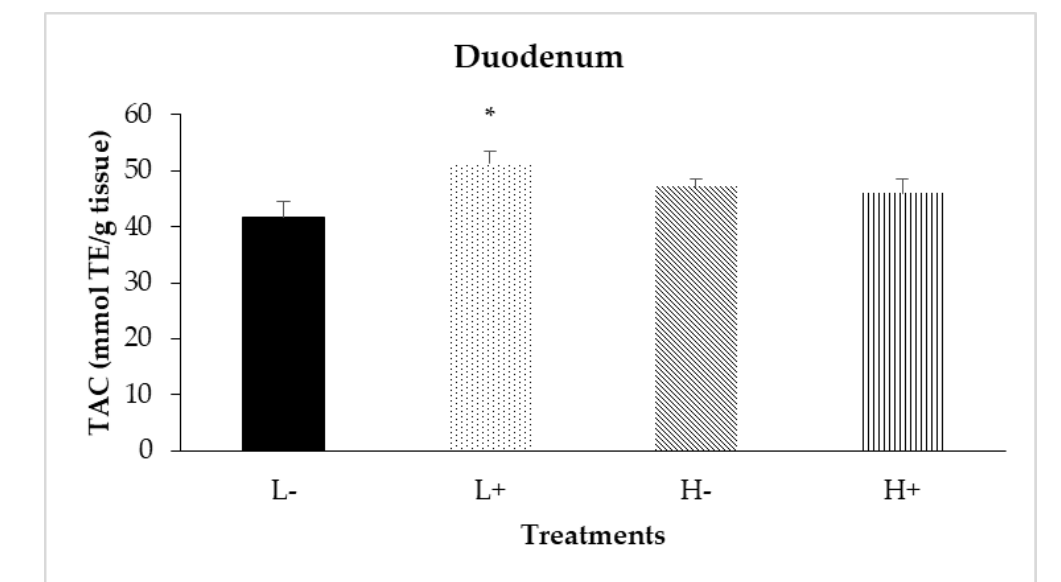
Figure 4. Interaction effects of diet type and phytogenic feed additive (PFA) supplementation on total antioxidant capacity (TAC) of duodenal mucosa of 42-day-old broilers. Columns indicate treatments means + SD, and the asterisk denotes statistical difference ( P D×P = 0.024).